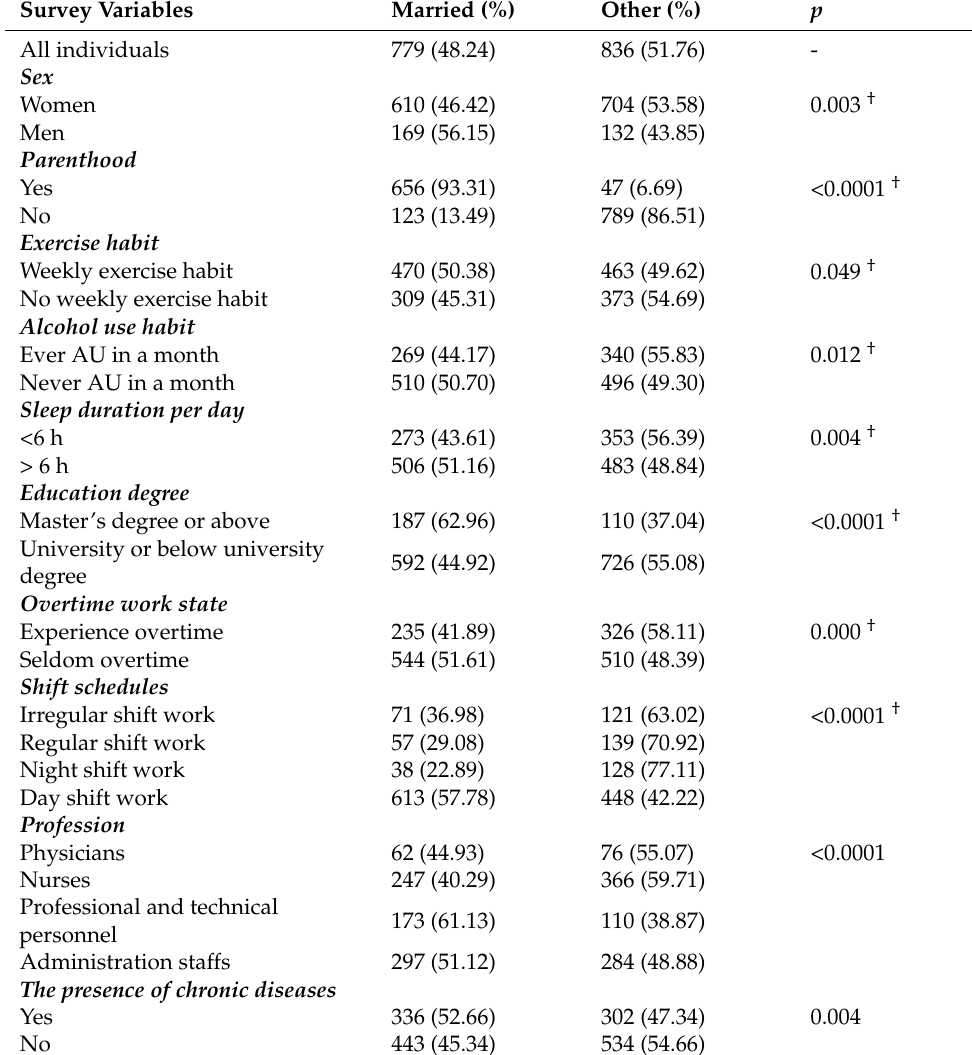
Table 3. Contingency Table Analysis for Categorical Variables and Marital